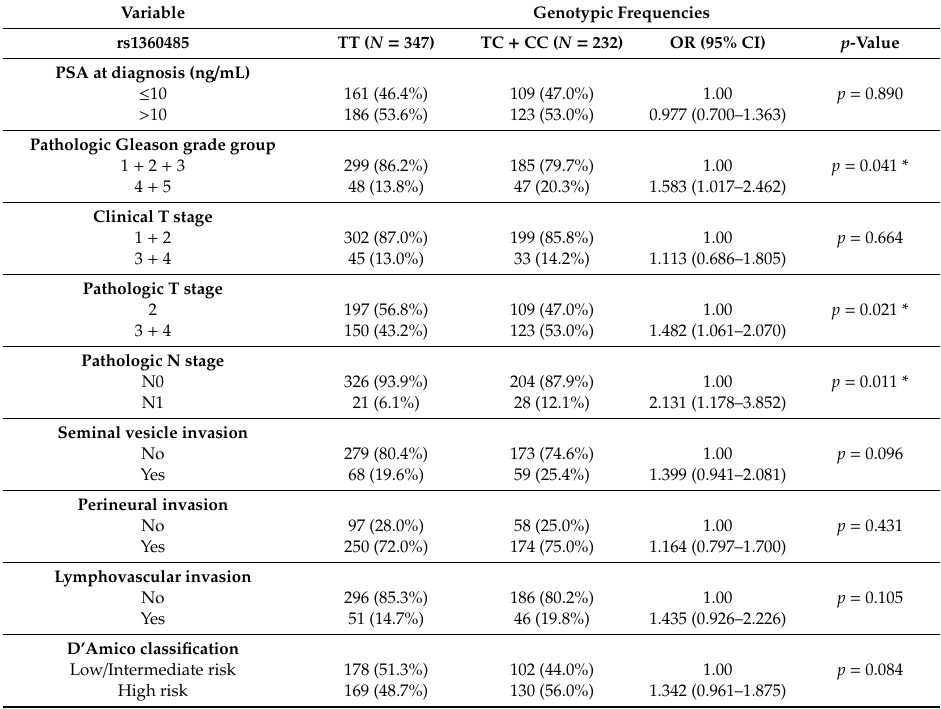
Table 5. Odds ratios (ORs) and 95% confidence intervals (CIs) of clinical status and HMGB1 rs1360485 genotypic frequencies in 579 patients with prostate